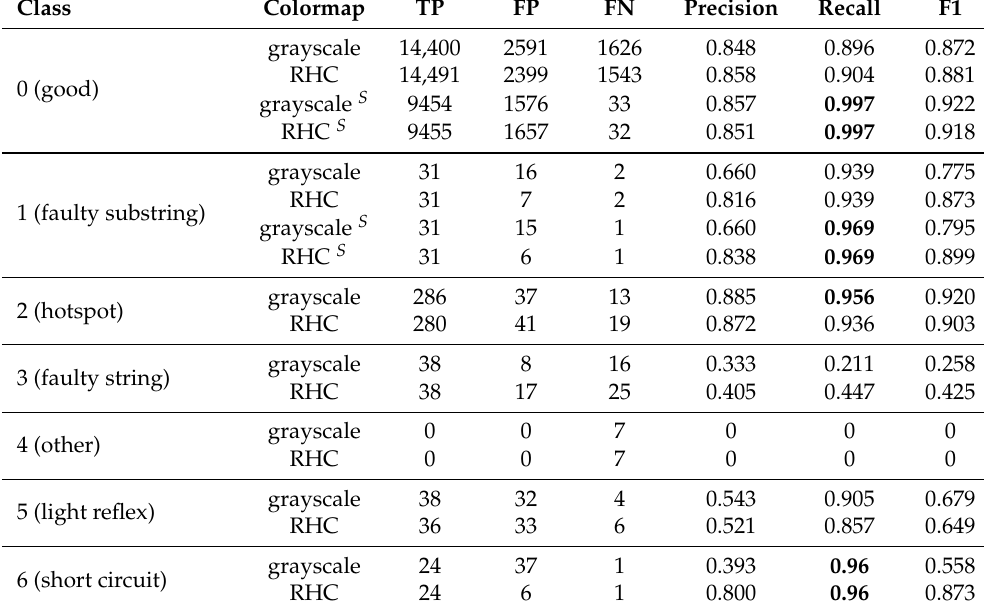
Table 5. Metrics for the test data for the second group of